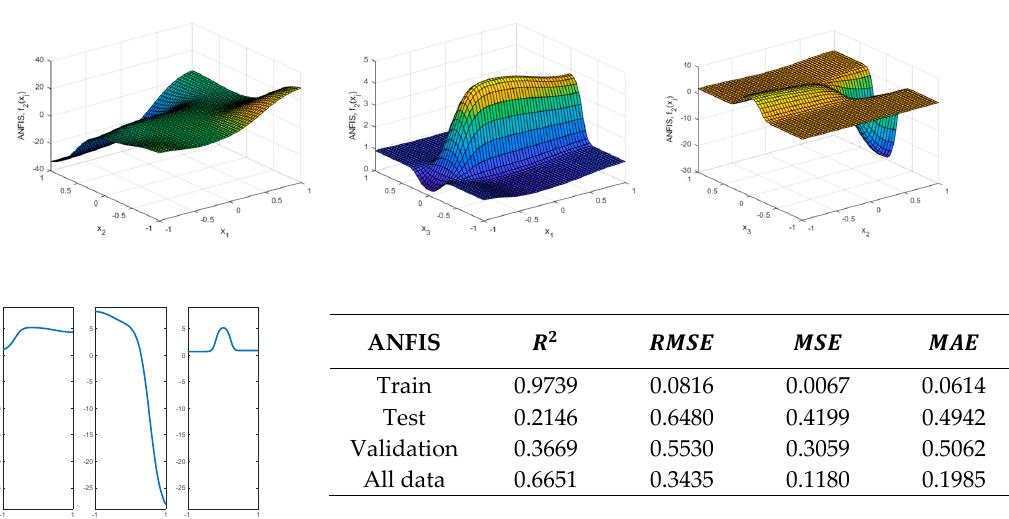
Figure 24. Response surface obtained with the zero-order Sugeno FIS employed for modeling f 2 using three Gaussian membership functions for the inputs along with an ANFIS (100 epochs, 27 fuzzy rules).